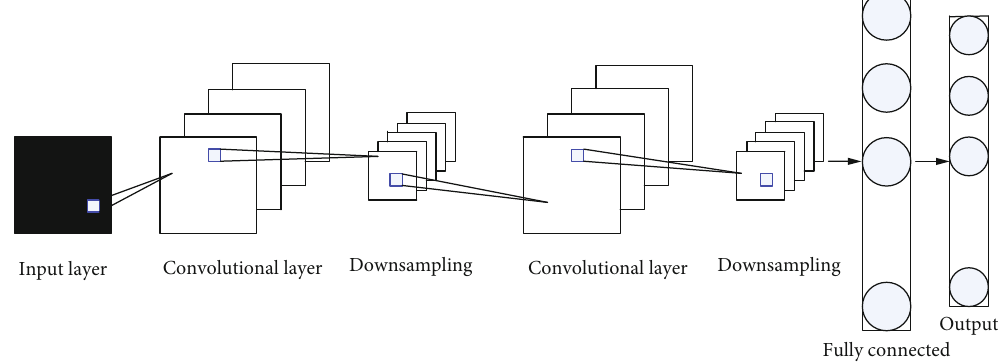
Figure 4: Convolutional neural network structure